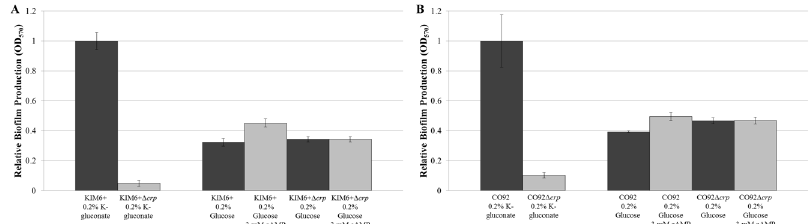
containing either 3 mM cAMP prepared in K-phosphate buffer or an equal volume of plain K-phosphate buffer. (B) Relative biofilm production of CO92 and CO92 Δ crp when grown in BCS medium supplemented with 0.2% glucose containing either 3 mM cAMP prepared in K-phosphate buffer or an equal volume of plain K-phosphate buffer. Identical source inoculum per strain was utilized for each media type. Error bars reflect standard deviation from the mean derived from two independent experiments, each consisting of 6 technical replicates. No statistically significant change in crystal violet absorption as determined by one-way ANOVA was calculated for both the crp -deficient mutants and the respective parental controls when cultured in media containing 3mM cAMP or an equal volume of K-phosphate buffer.